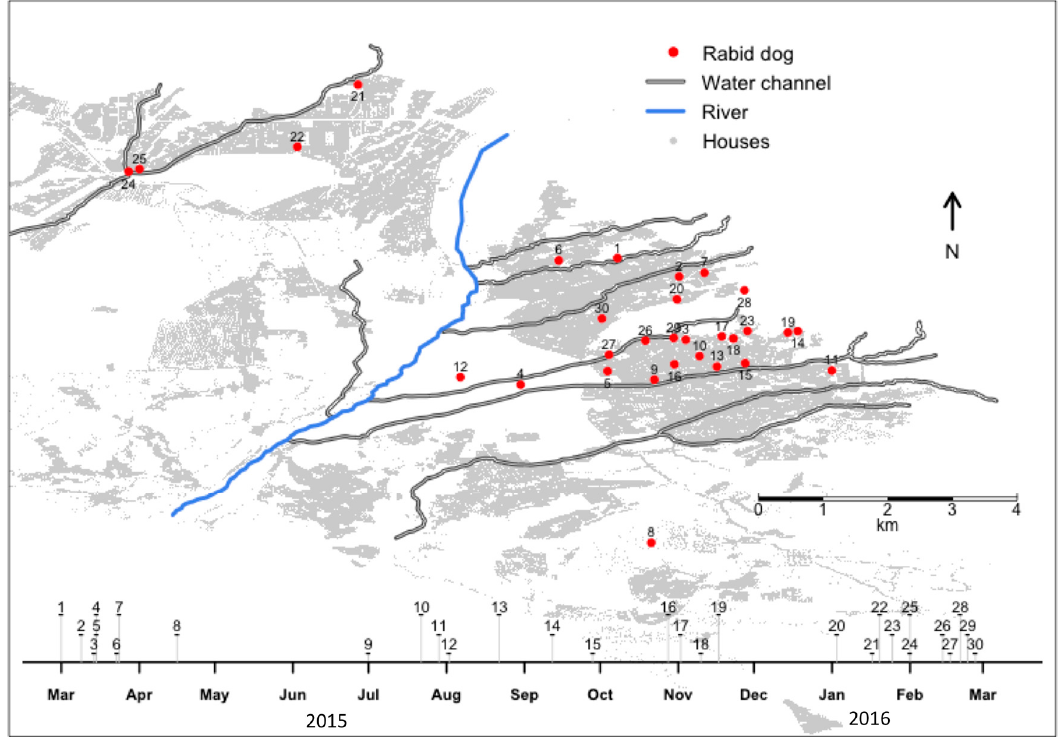
Figure 1. Spatio-temporal distribution of laboratory-confirmed rabid dogs and water channels system in the city of Arequipa, March 2015–March 2016 (different heights in timeline are used only to avoid overlap).